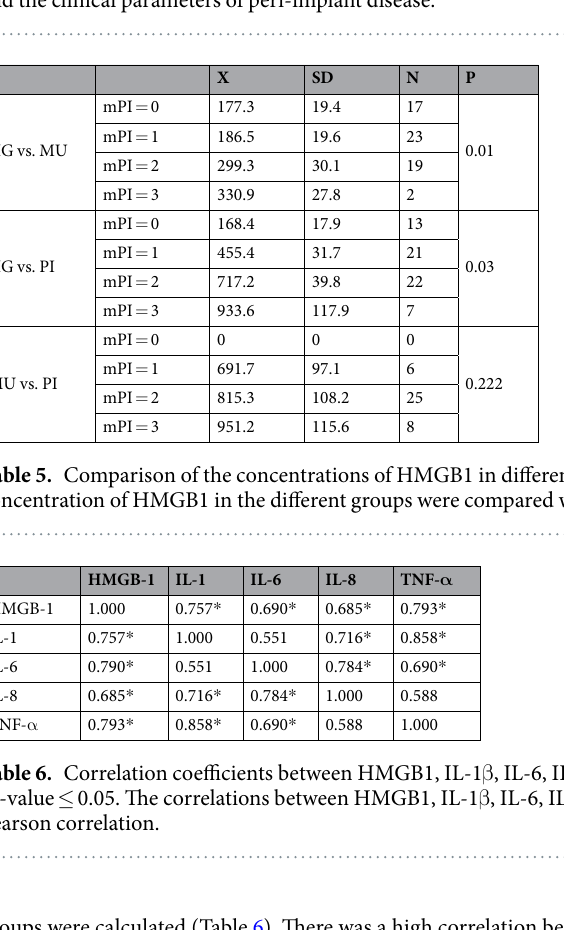
groups were calculated (Table 6). There was a high correlation between the HMGB1 level and the expression of IL-1 β and TNF- α and a moderate correlation between the HMGB1 level and the expression of IL-6 and IL-8. Discussion